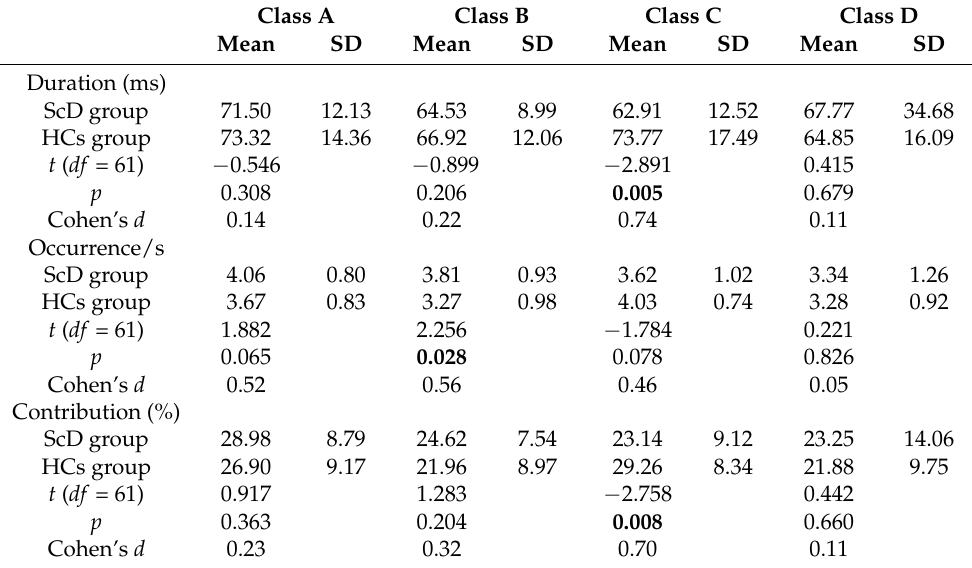
Bold values indicate statistical significance ( p < 0.05). Microstate transitions probability. The main effect of microstate transition pairs was significant, F (11, 371) = 3.69, p = 0.026, η 2 = 0.049. The main effect of the group was not significant, F (1, 61) = 0.360, p = 0.55, η 2 = 0.006. The interaction effect between group and microstate transition probability was significant, F (11, 371) = 2.50, p = 0.004, η 2 = 0.039. The results of post hoc tests indicated the microstate transition pairs significantly increased from microstate class A to microstate class B ( t = 3.288, df = 61, p = 0.002, Cohen’s d = 0.827) and from microstate class B to microstate class A ( t = 2.879, df = 61, p = 0.005, Cohen’s d = 0.737) for the ScD group than for the HCs group. The results also significantly increased from microstate class C to microstate class D ( t = − 2.399, df = 61, p = 0.019, Cohen’s d = 0.642) and class D to class C ( t = − 2.238, df = 61, p = 0.029, Cohen’s d = 0.573) for the HCs group than for the ScD group. The other microstate transition probabilities were not significant between the ScD and HCs (A → C: p = 0.20; A → D: p = 0.54; B → C: p = 0.44; B → D: p = 0.27; C → A: p = 0.25; C → B: p = 0.50; D → A: p = 0.71; D → B: p = 0.22). Significant results for microstate transition probability are shown in Figure